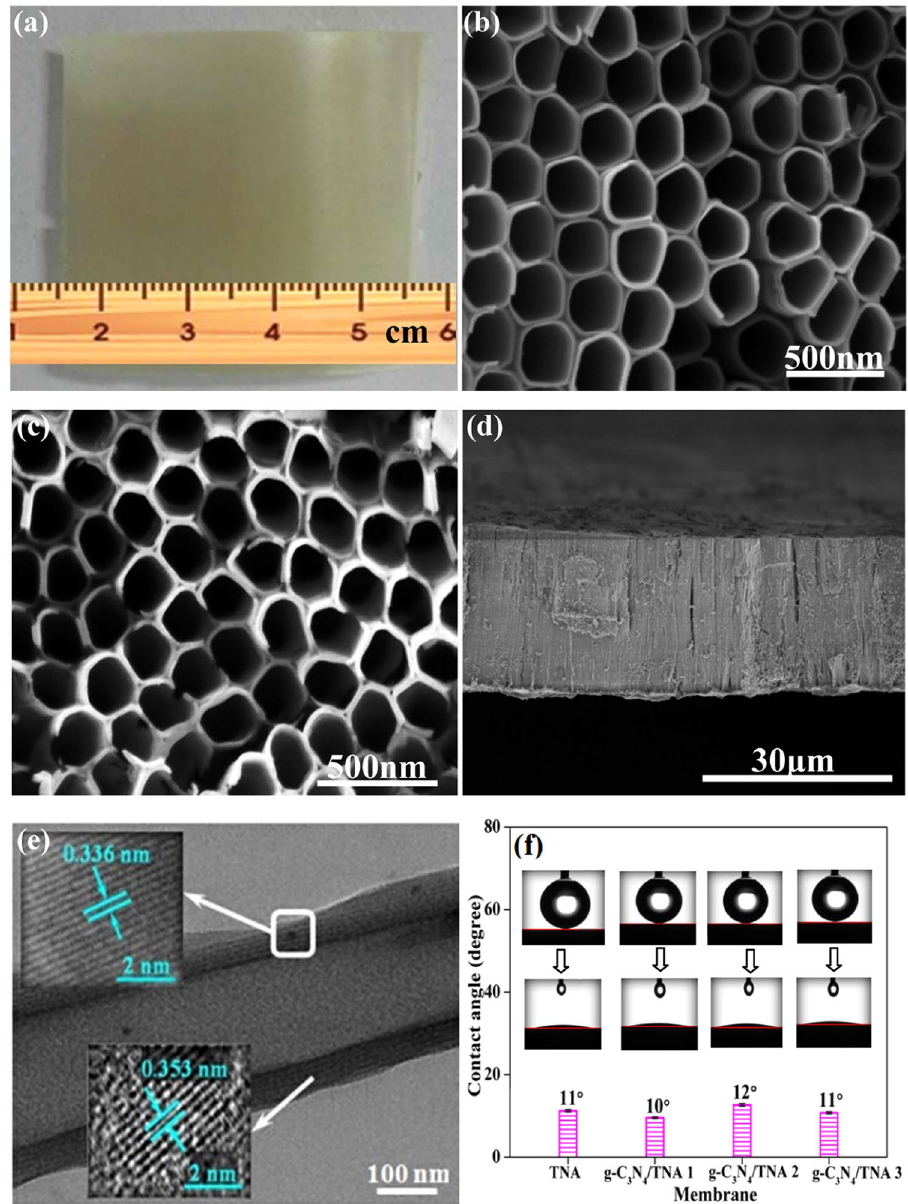
Figure 1. ( a ) Digital photograph of the g-C 3 N 4 /TNA membrane; SEM images of the g-C 3 N 4 /TNA membrane with ( b ) top view, ( c ) bottom view, and ( d ) cross-sectional view; ( e ) TEM images of a TiO 2 nanotube with immobilized g-C 3 N 4 QDs; ( f ) Water contact angle changes of TNA membrane, g-C 3 N 4 /TNA membrane 1, 2 and